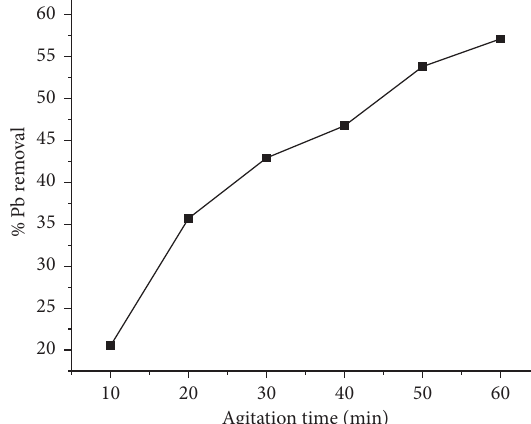
Figure 2: Efects of agitation time on lead removal.